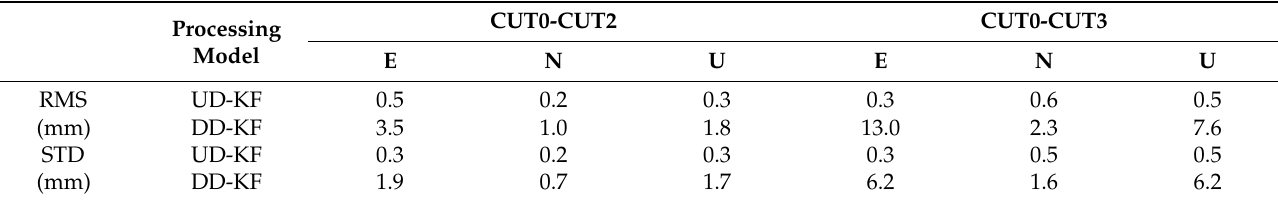
Table 3. The processing schemes for different baselines.